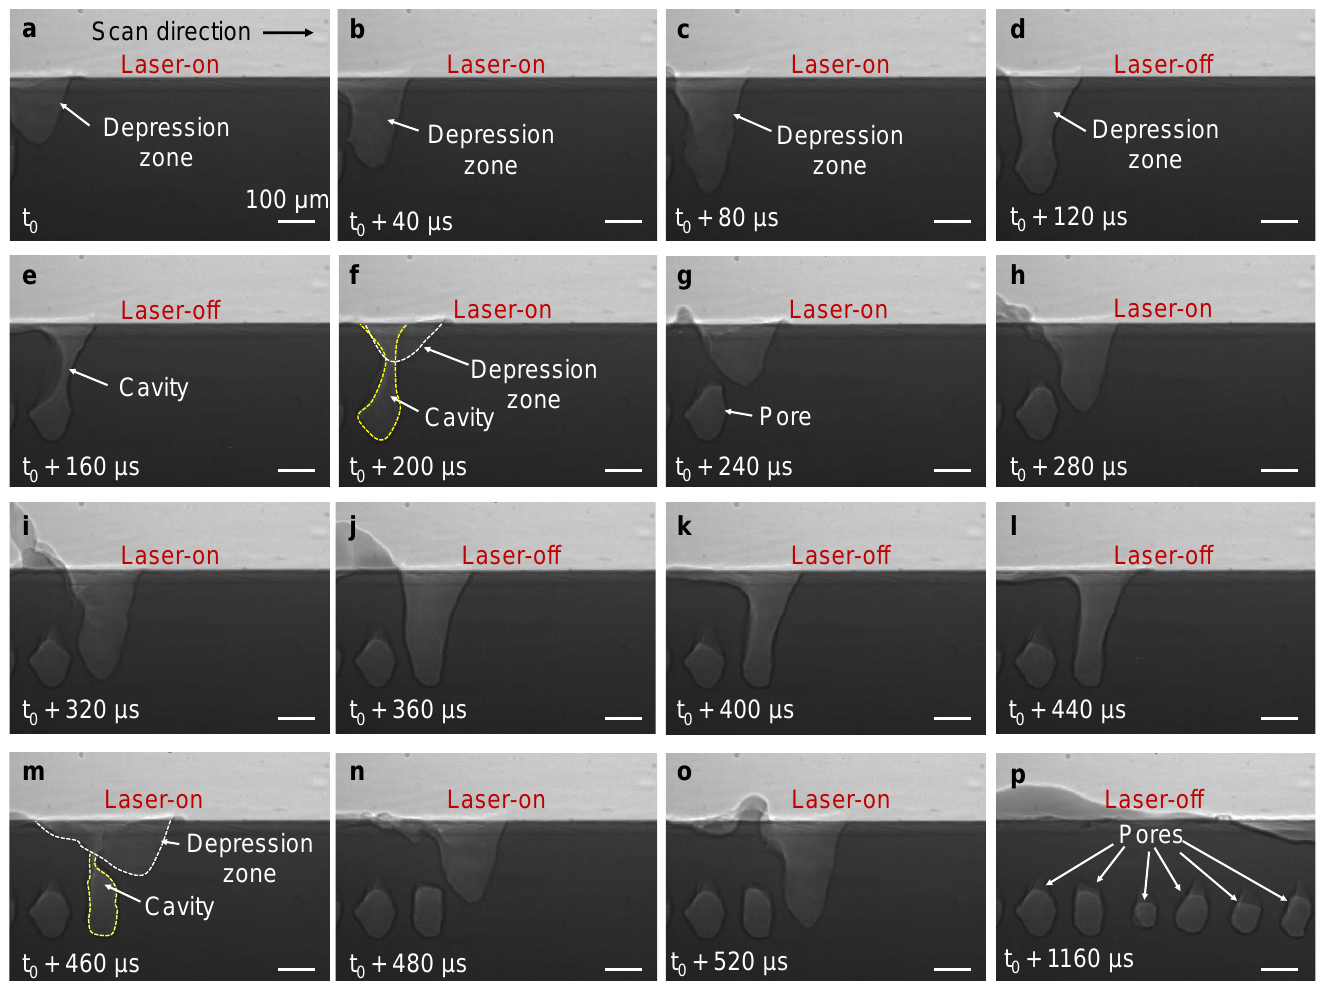
Figure 5. Pore pattern formation from cavities at low laser frequency: ( a – p ) Dynamic X-ray images showing the formation of pores from a cavity during pulsed-wave laser melting of Ti-6Al-4V at a laser frequency of 4 kHz, a duty cycle of 60%, a laser power of 470 W and a laser scan speed of 0.5 m/s. The pore formation from cavity in two consecutive pulses is shown in ( a – o ). Note that some image frames during the laser-on period and laser-off period have been skipped. The movie showing pore formation dynamics is available in the Supplementary Material (Movie S8).